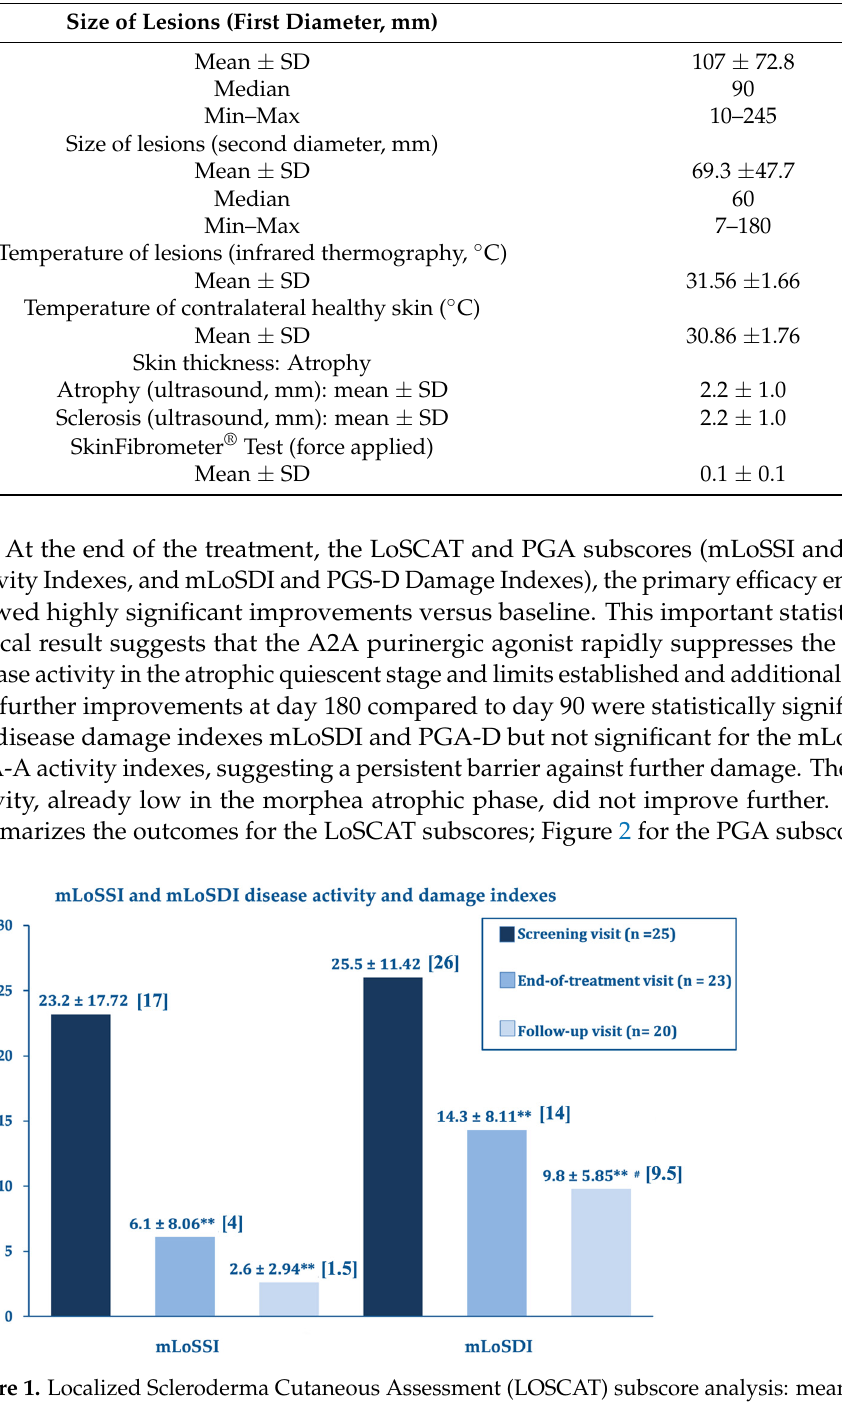
Figure 1. Localized Scleroderma Cutaneous Assessment (LOSCAT) subscore analysis: mean changes ± standard deviation and medians of the mLoSSI disease activity and mLoSDI disease damage indexes; end-of-treatment visit (day 90) and follow-up visit (day 180) vs. screening visit (baseline). ** p < 0.0001 vs. baseline screening visit, # p = 0.030 vs. day 90.